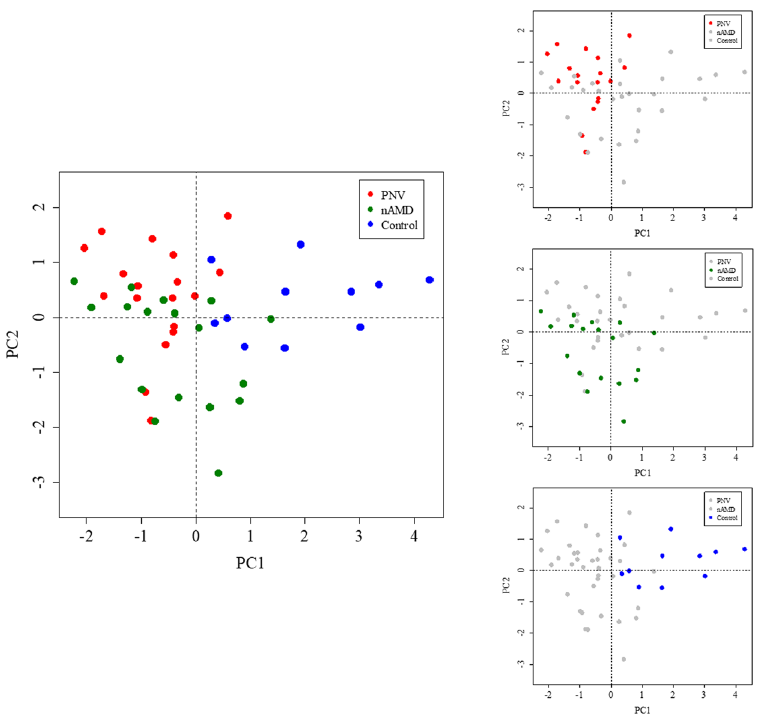
Figure 2. Principal component (PC) analysis of the data from four cytokines (VEGF-A, MCP-1, bFGF and GM-CSF). Neovascular age-related macular degeneration (nAMD; green), pachychoroid neovasculopathy (PNV; red) and control (blue) are plotted in a space defined by PCs 1 and 2, which are the two best axes representing the entire dataset. In the PC-1 axis, the control group is well separated from the other two groups. PNV and nAMD are distinguished by the PC-2 axis. The results of PC analysis indicate that the three pathological conditions form clusters and can be distinguished by four types of cytokines. VEGF-A = vascular endothelial growth factor A; MCP-1 = monocyte chemoattractant protein 1; bFGF = basic fibroblast growth factor; GM-CSF = granulocyte macrophage colony-stimulating factor.